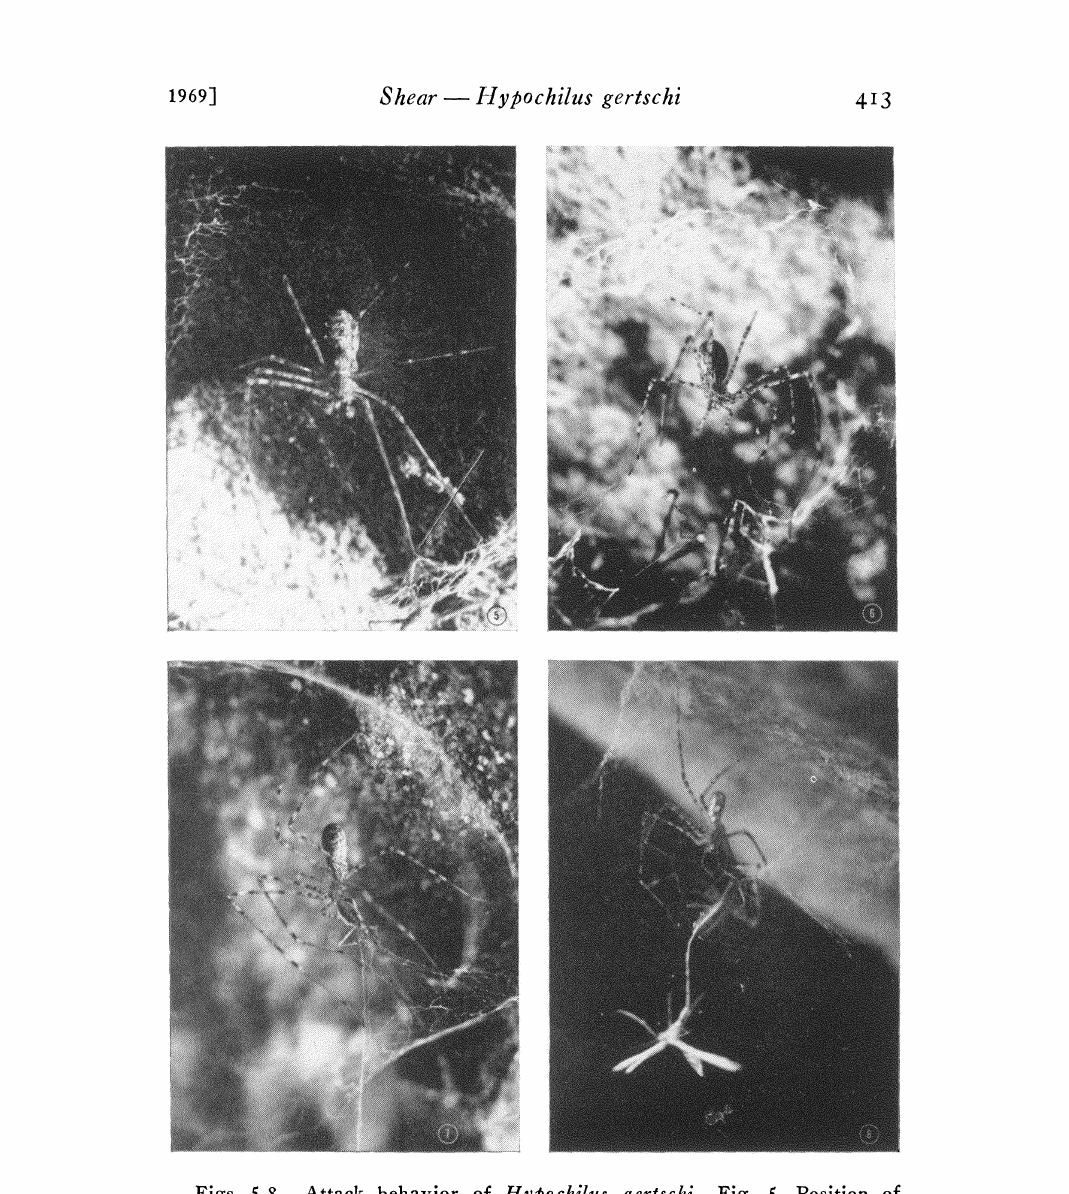
Figs. 5-8. Attack behavior of Hylochilus gertschi. Fig. 5. Position of H. gertschi in web. Arrow points out that first and second legs hold sides of lampshade. Fig. 6. H. gertschi pulling prey to lampshade center. Fig. 7. H. ertschi biting prey. Fig. 8. Response to a second prey; see